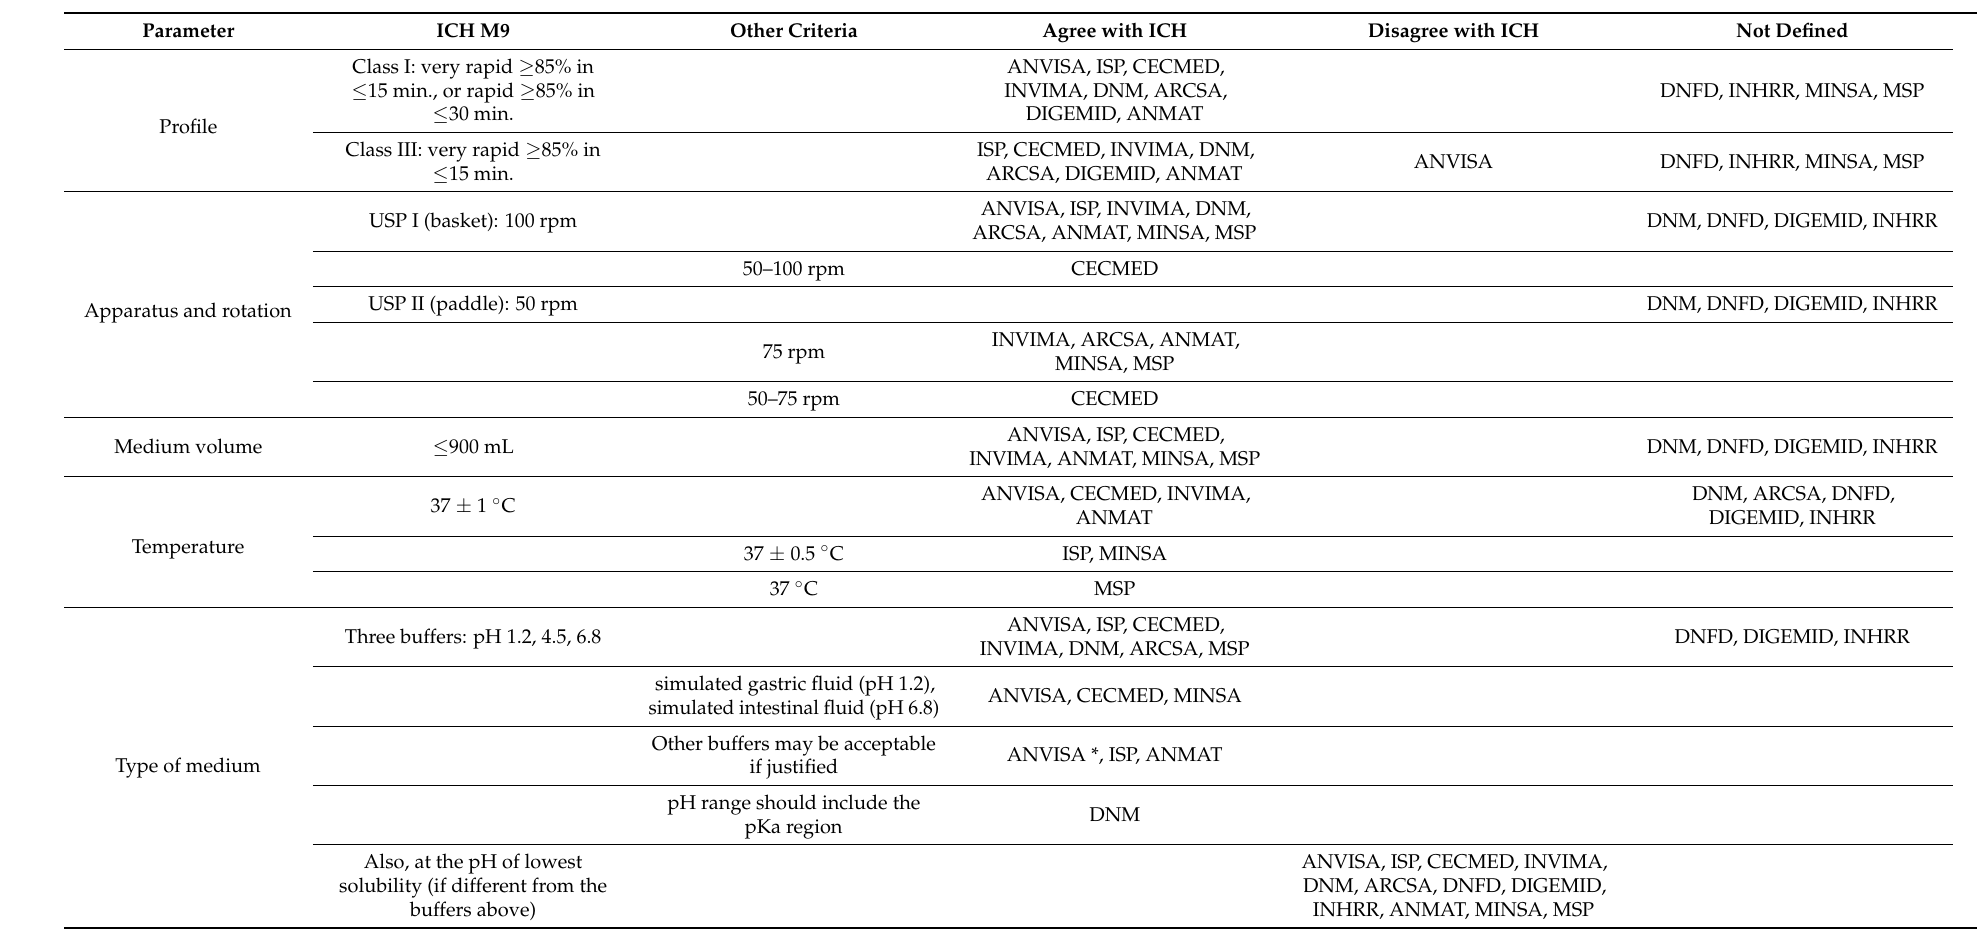
Table 4. Comparison of dissolution requirements for BCS-based biowaivers between ICH and Latin American regulatory